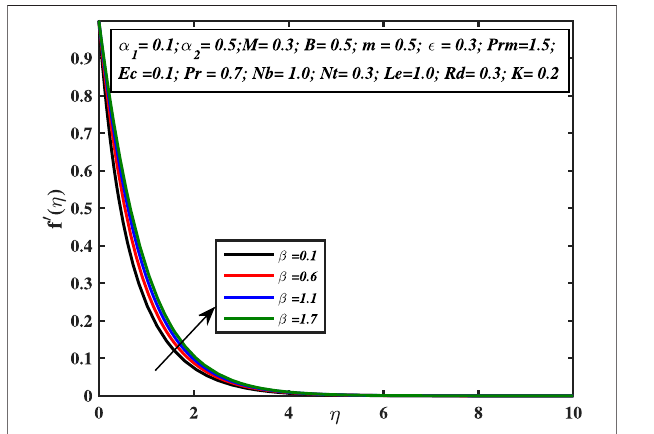
FIGURE 7 | Impact of K on the θ ( η ) curve.